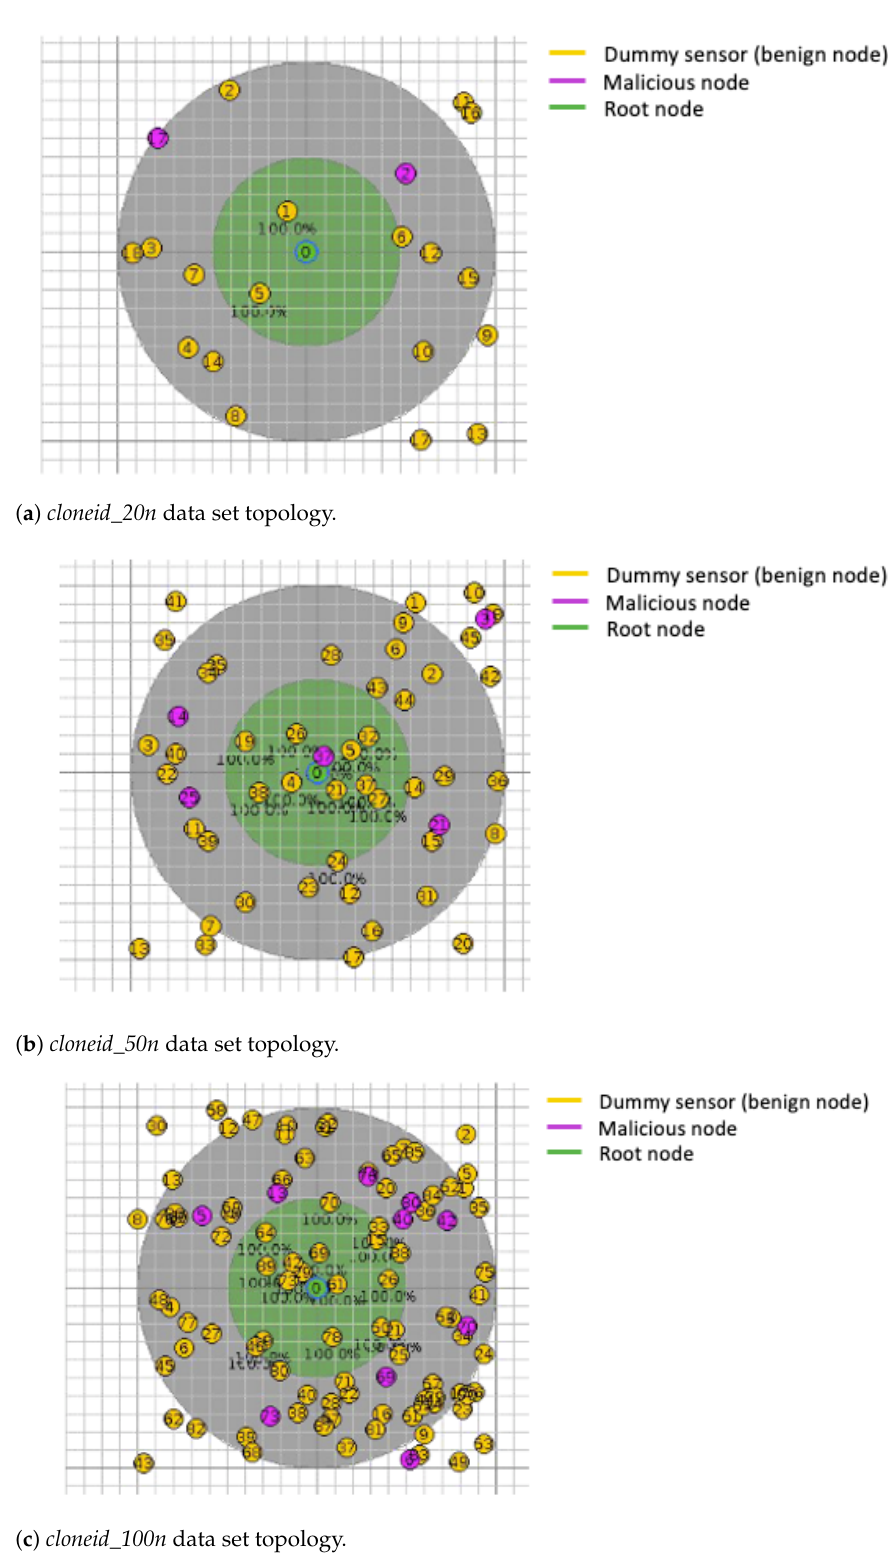
Figure 7. Sensors employed to simulate a Clone ID attack, with different topologies and node